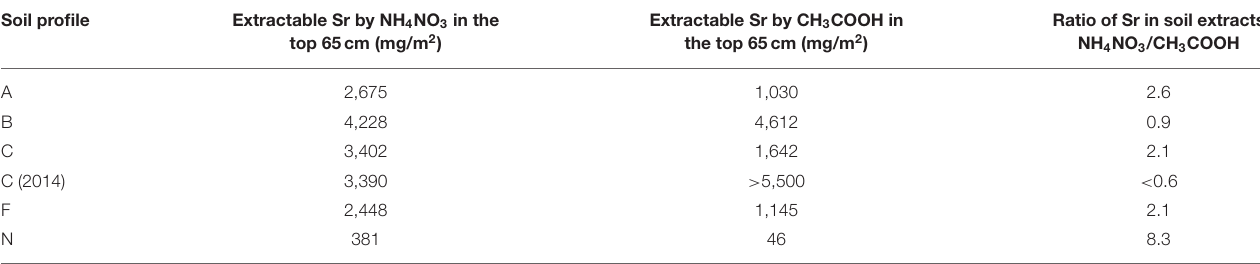
TABLE 2 | The amount of Sr in the top 65cm of one square meter of each soil profile that is extractable with ammonium nitrate and acetic acid, and the ratio between the two. Soil